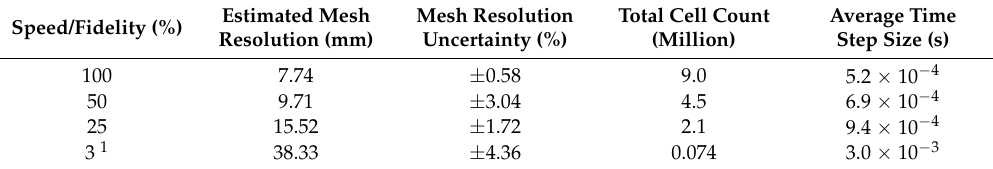
Table 2. Discretization parameters corresponding to the different speed/fidelity ratios.